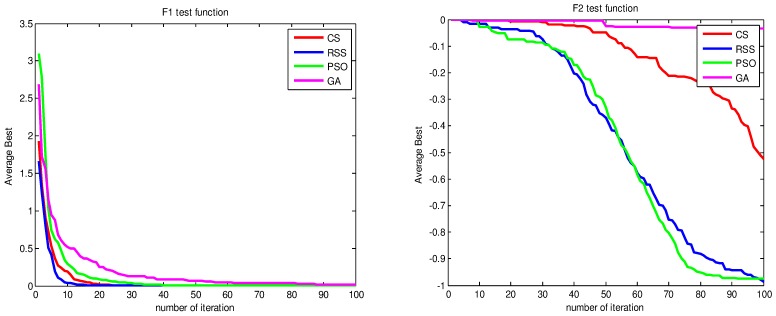
AB convergence of CS, RSS, PSO and GA for minimization of (a) F1 and (b) F2.